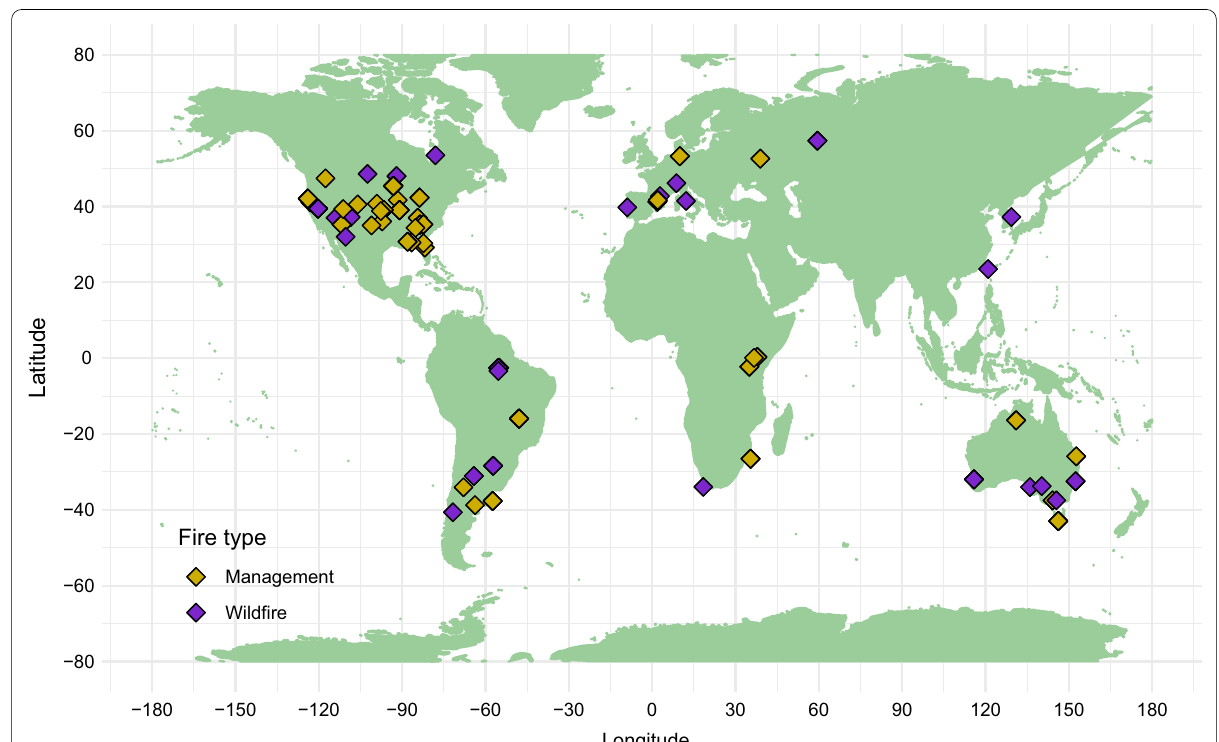
Fig. 2 Spatial distribution of the 162 studies included in the meta‑analysis. The type of fire is represented using different colors: purple—wildfire,